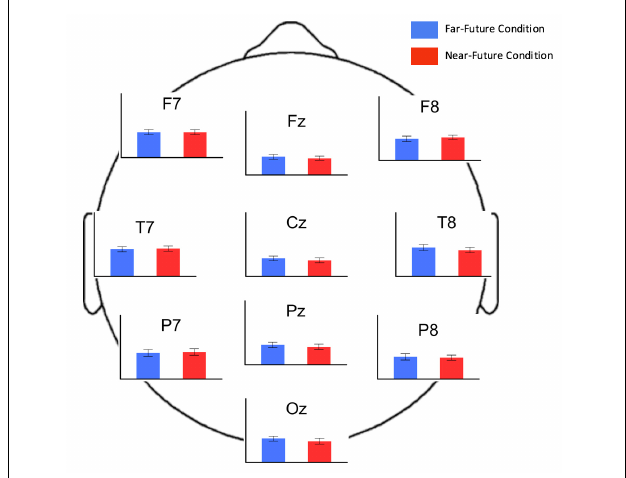
FIGURE 5 | Mean EEG beta-frequency power values in log ( µ V2) for selected electrode sites by priming condition. All bar charts are scaled 0 to − 10 in units of log( µ V2), with negative plotted up and error bars reflecting the standard